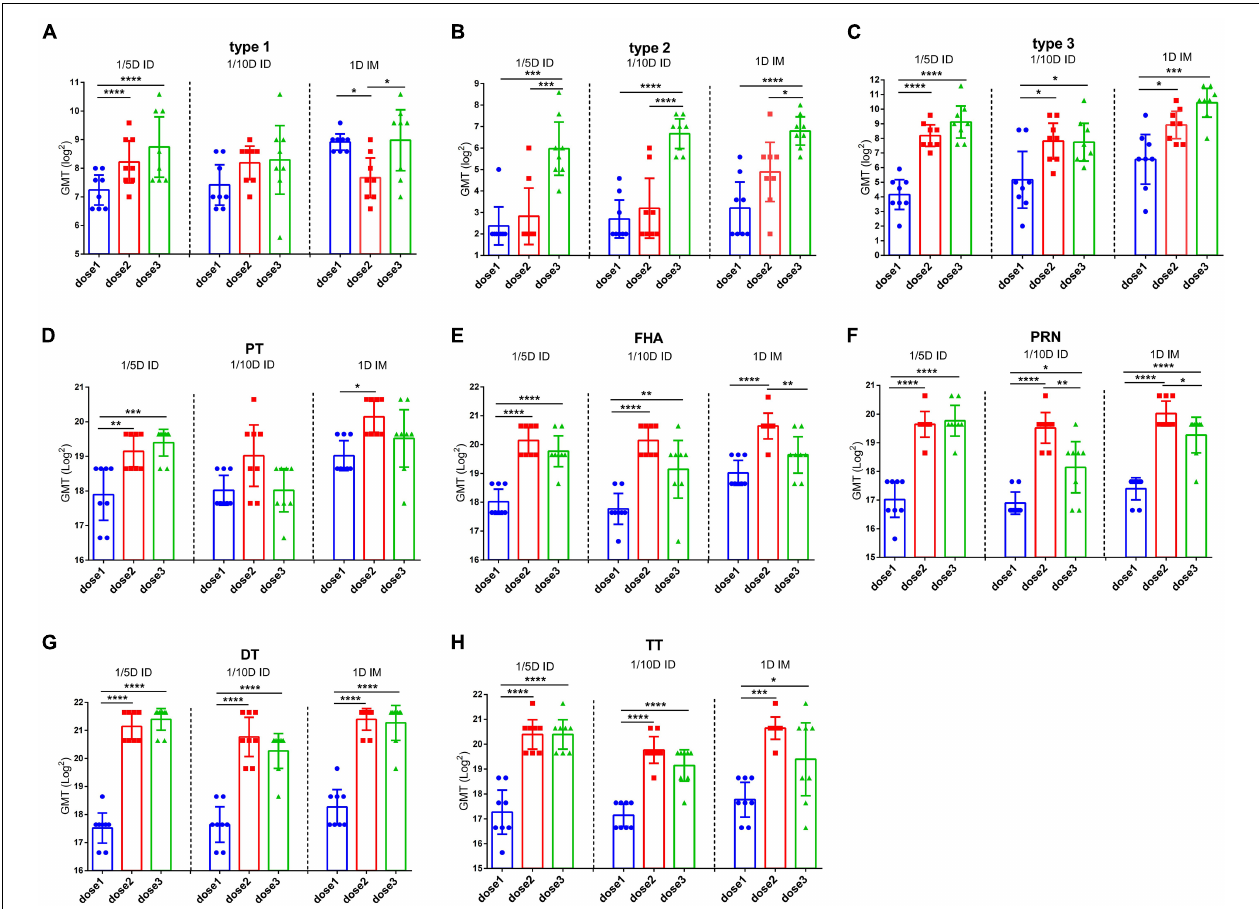
FIGURE 3 | The efficacy of booster immunization in the same group. Poliovirus (A) type 1, (B) type 2 and (C) type 3 neutralizing antibody levels and (D) PT, (E) FHA, (F) PRN (G) DT and (H) TT antibody levels were compared between the different vaccination in the same group. The results were shown as the log2 of antibody titer of the geometric mean ± 95% CI. The PBS group results are below the detection limit and were not shown in figure. Data were analyzed using an one-way ANOVA model with Tukey’s multiple comparisons test. * P < 0.05, ** P < 0.01, *** P < 0.001, and **** P < 0.0001 ( n =